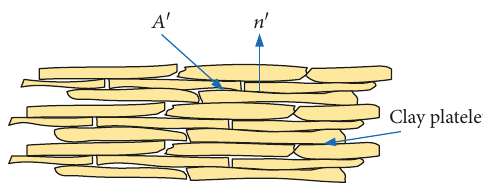
Figure 12: Schematic diagram of shale equivalent